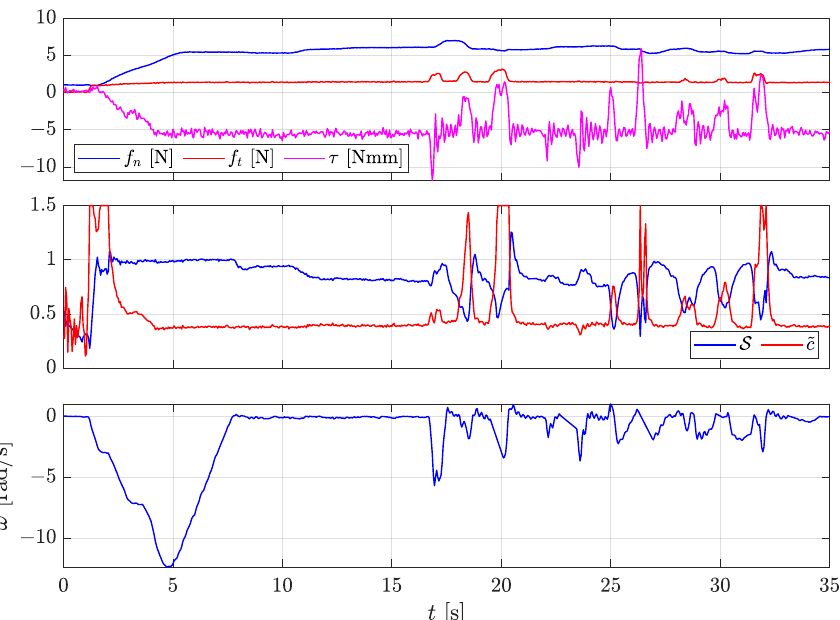
Figure 13. Second experiment: lifting the small resin block far from the CoG. Top plot: grasping force (blue), tangential load (red), torsional torque (magenta). Middle plot: slippage indicator (blue) and estimated ˜ c (red). Bottom plot: estimated slippage velocity around the CoR (cid:98) ω